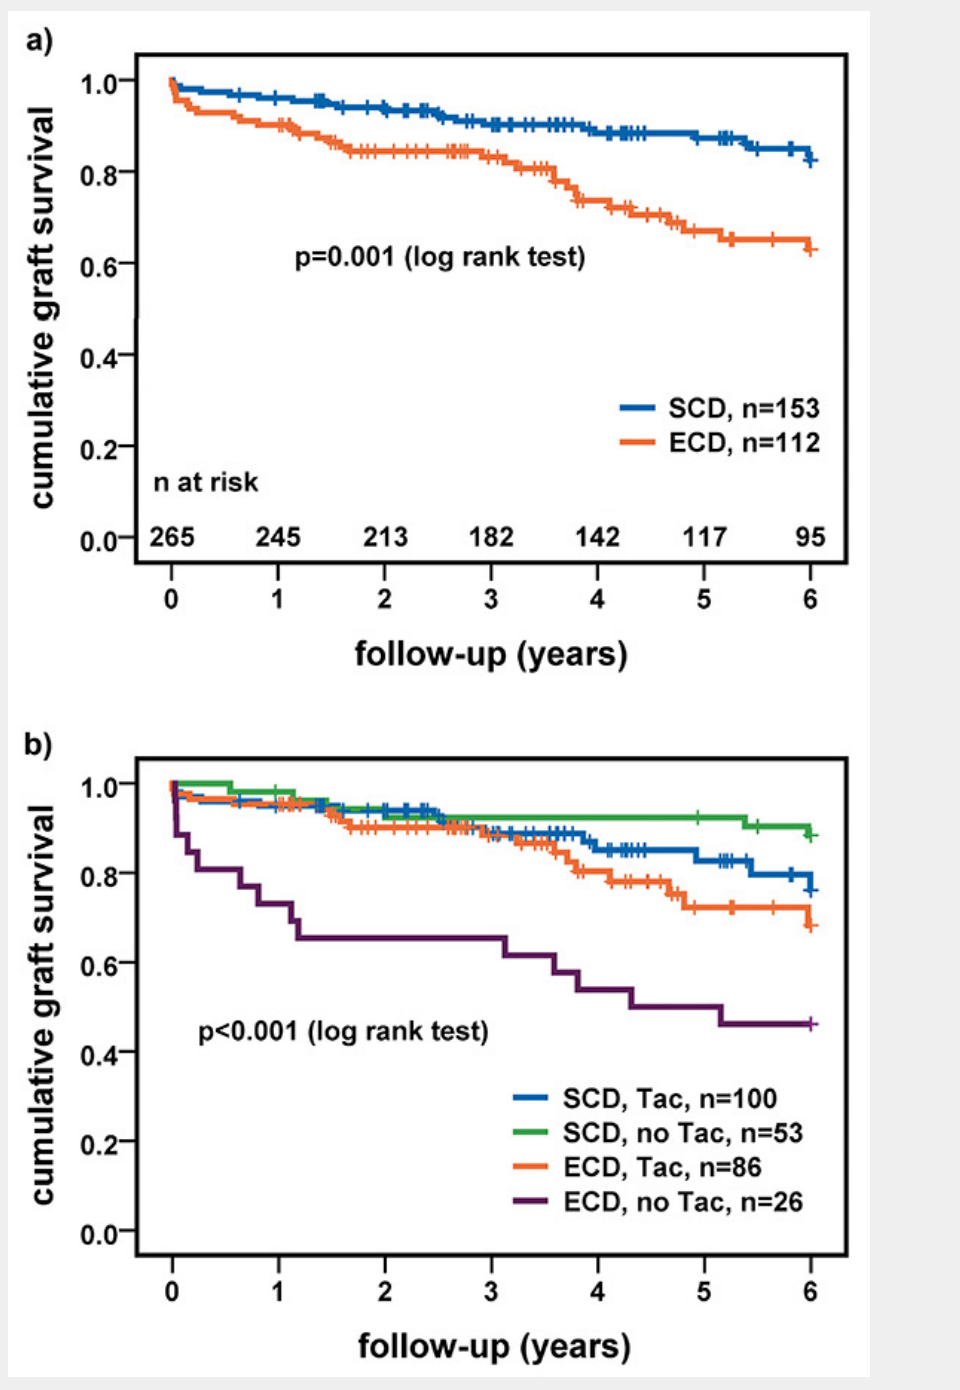
Figure 2 (a) Cumulative graft survival stratified by donor status. (b) Cumulative graft survival stratified by donor status and immunosuppression; p-values of difference between subgroups in figure 2b: ECD/Tac versus ECD/no Tac p = 0.008 (log rank test); SCD/Tac versus SCD/no Tac p = 0.1 (log rank test). ECD = expanded-criteria donor; SCD = standard-criteria donor; Tac =